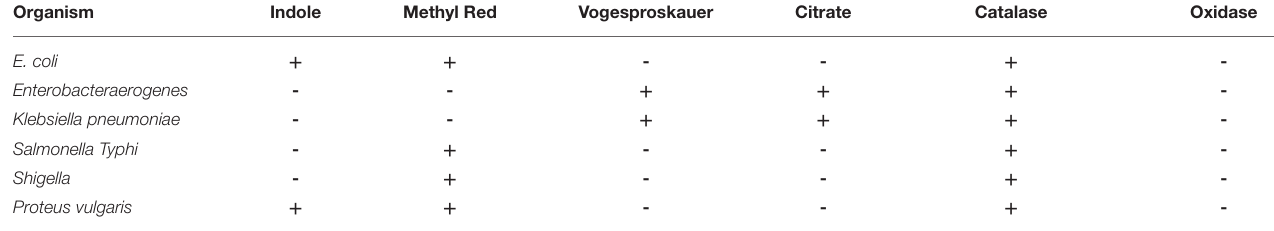
TABLE 5 | Biochemical characteristics of Enterobacteriaceae .